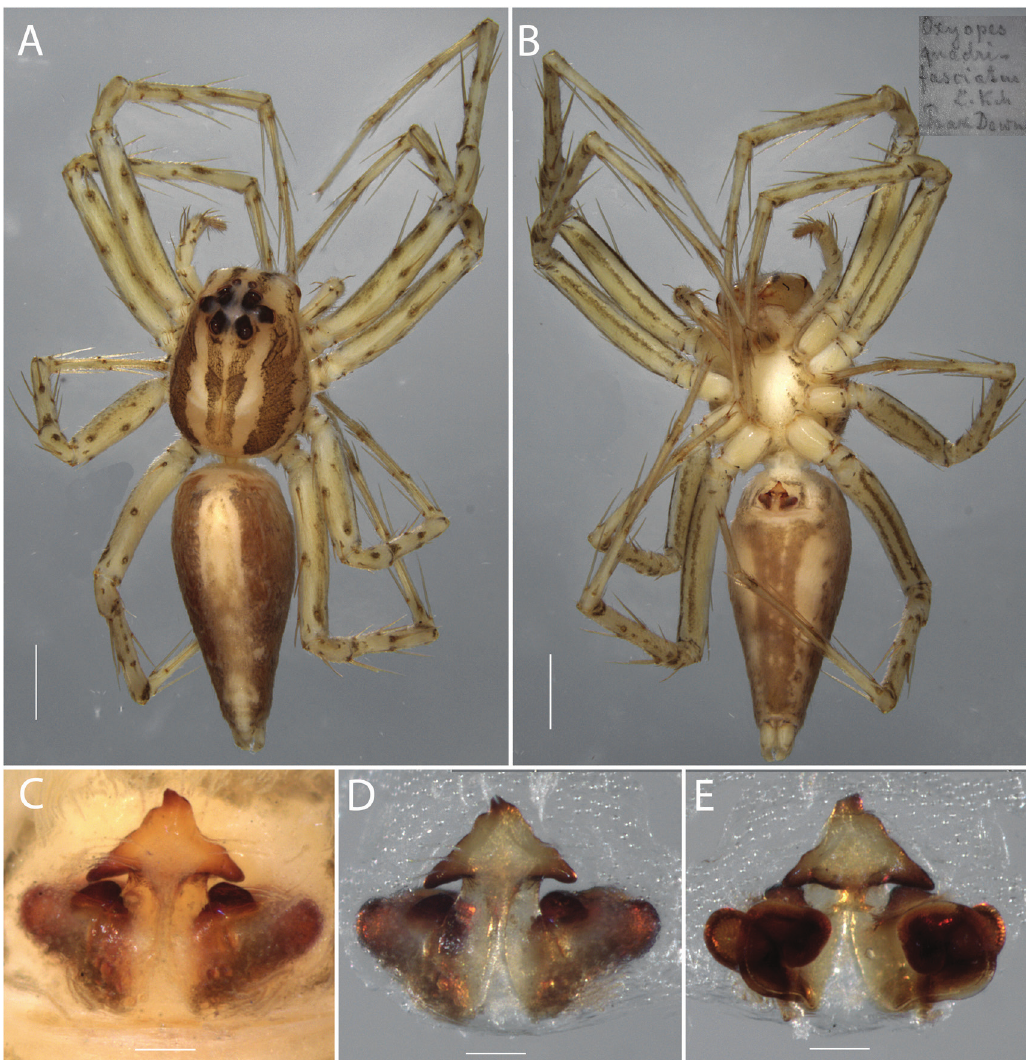
Figure 16. Oxyopes quadrifasciatus L. Koch, 1878, female holotype ( ZMH- A0000018): A , habitus, dorsal view; B , habitus, ventral view; C , epigyne, ventral view; D, epigyne, ventral view, cleared; E , epigyne, dorsal view, cleared. Scale bars: habitus 1.0 mm, epigyne 0.1